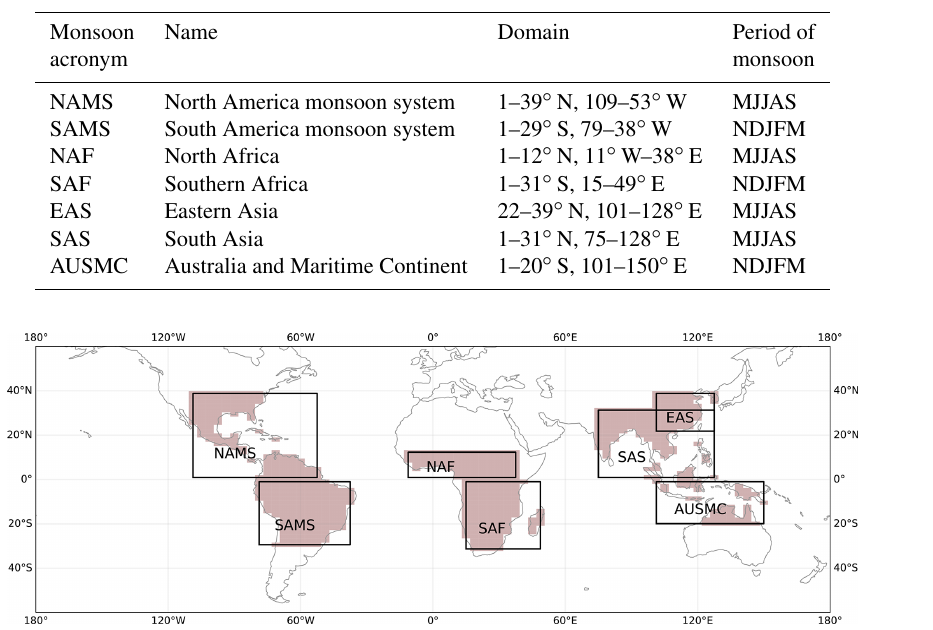
Table 1. List of regions and the associated monsoon period. Only land grid points are used in the analysis. See Fig. 1 for the graphical representation of regions.